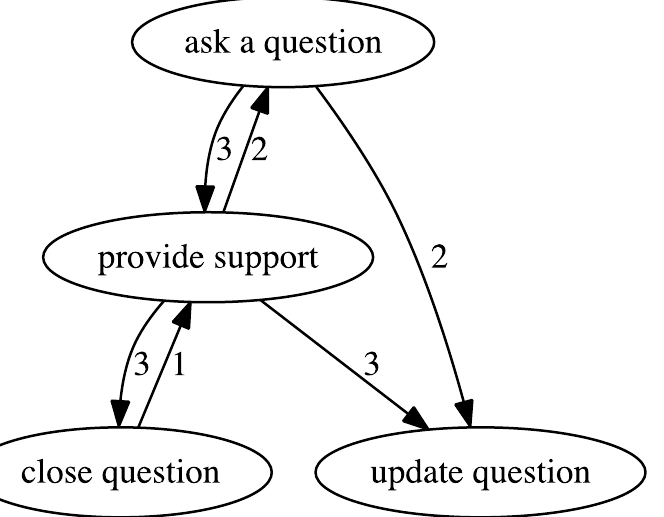
Fig 4. Workflow digraph containing the actions relating to “support”. Numbers between each directed edge (including self referential connections) indicate the number of instances of this connection.